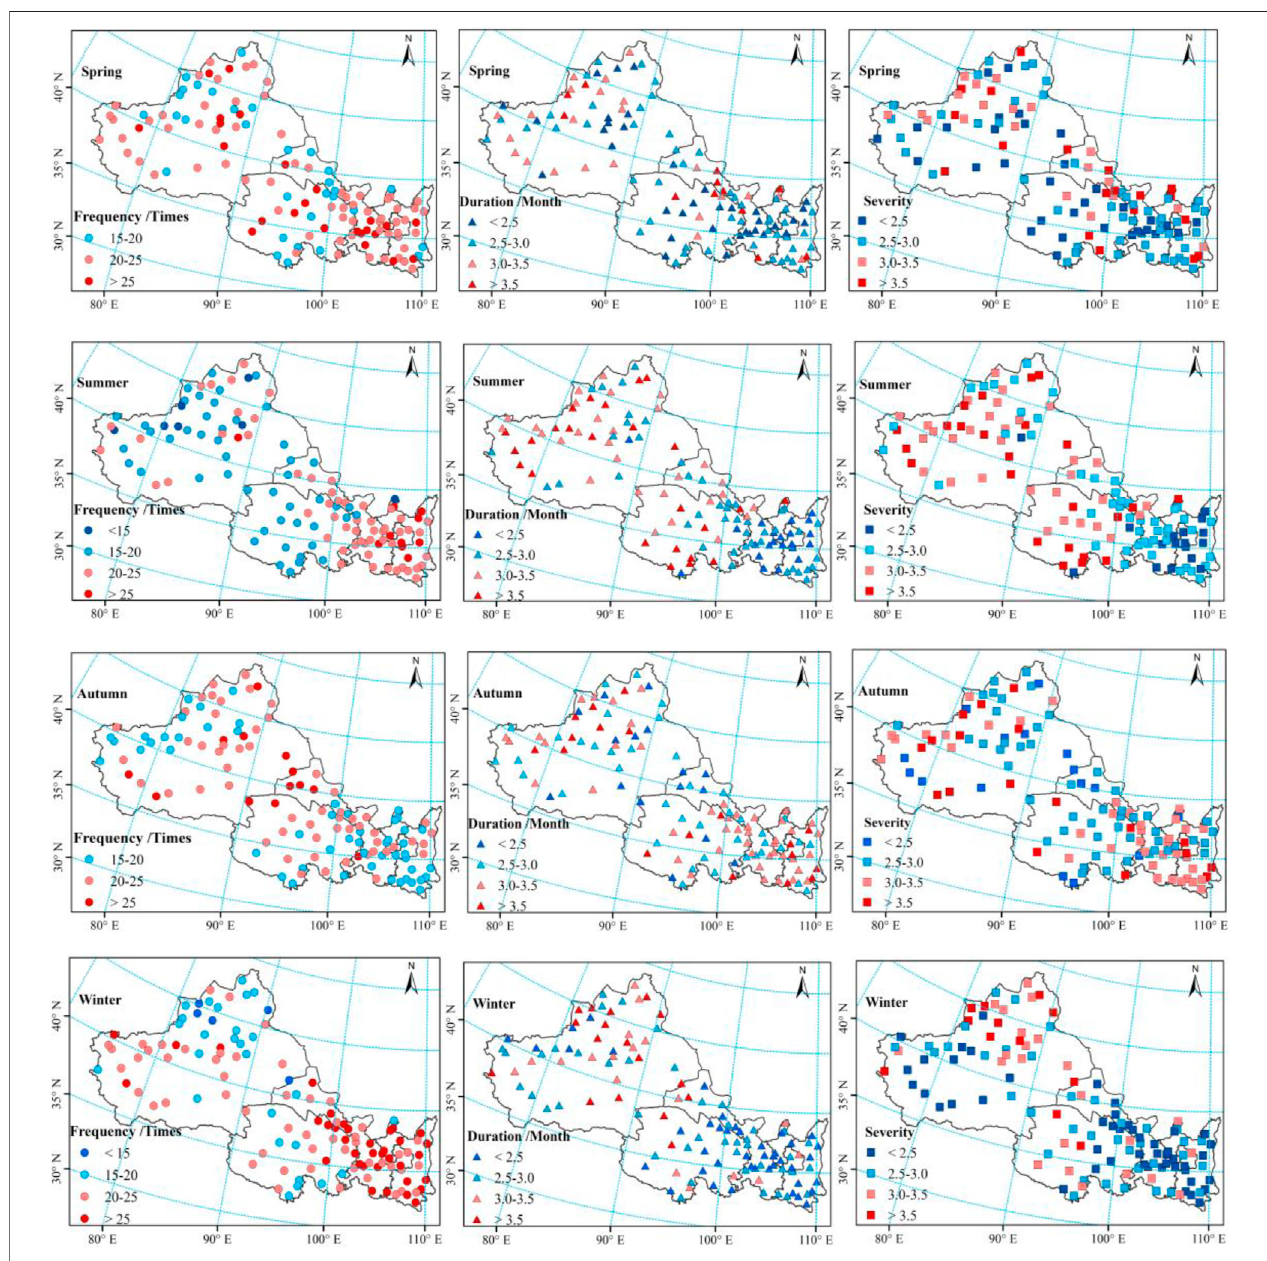
FIGURE 10 | Spatial distribution of seasonal drought characteristic